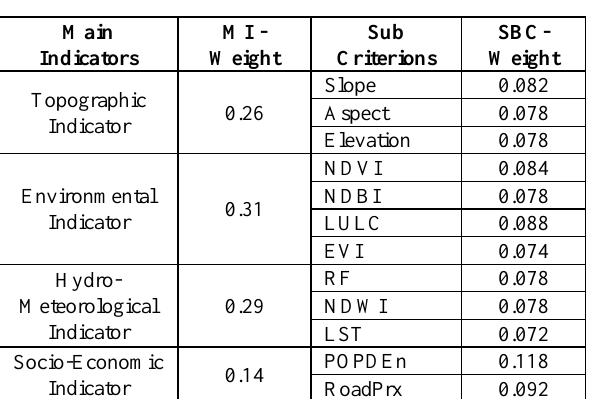
Figure 3. Thematic layers of EI and SEI